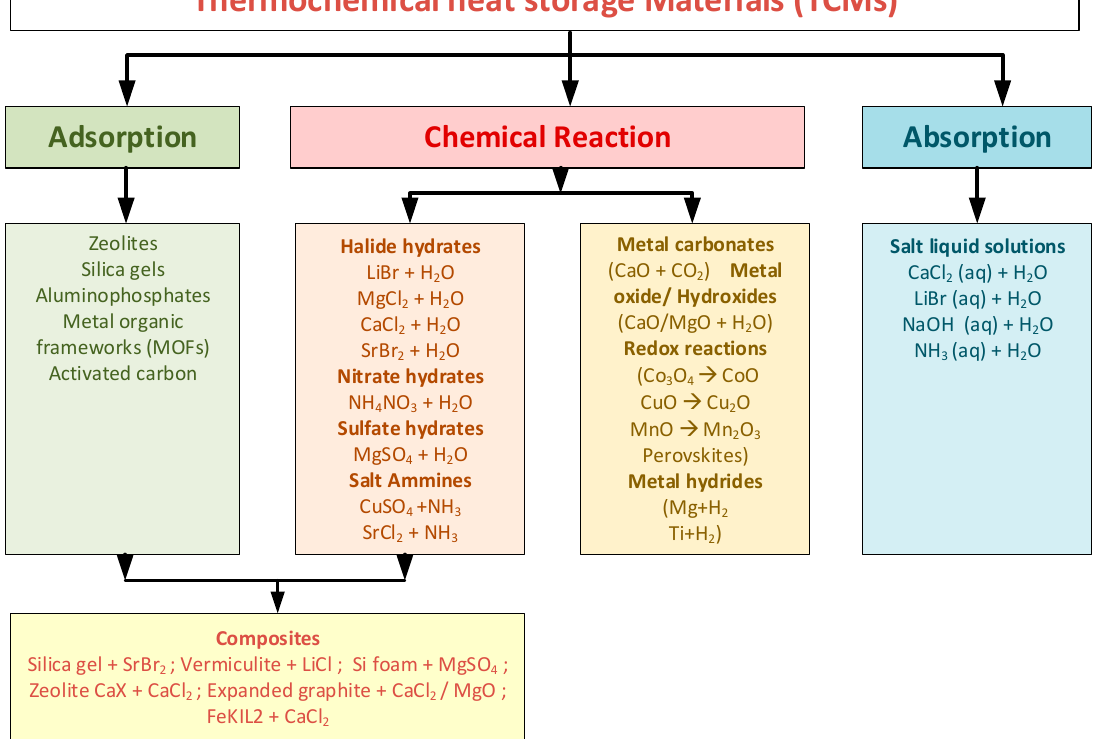
Figure 4. Thermochemical heat storage materials (TCMs) categorization based on the type of interaction: adsorption, chemical reaction or absorption.